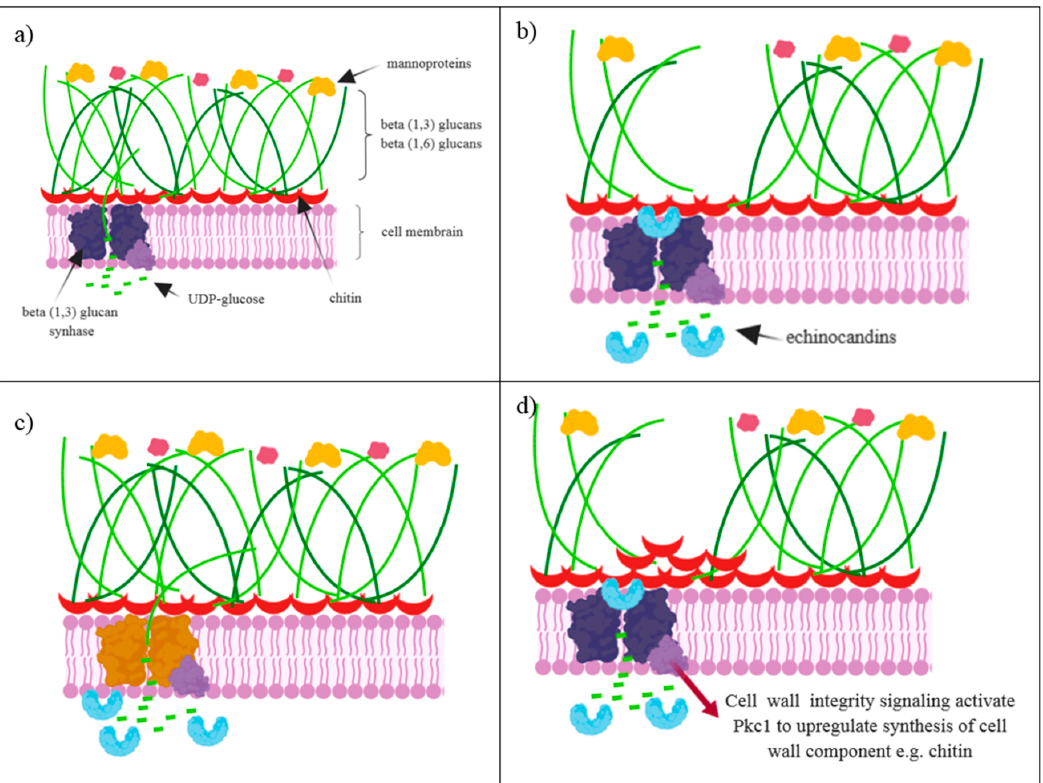
Figure 2. ( a ) The structure of a fungal cell wall; ( b ) Echinocandins act as noncompetitive inhibitors of β -(1,3)-D-glucan synthase. Inability of the microorganism to biosynthesize β -(1,3)-D-glucans leads to osmotic instability and cell death; ( c ) Nucleotides substitutions in the gene encoding glucan synthase contribute to the lack of echinocandin interactions with the enzyme; ( d ) Another mechanism of echinocandin resistance is to cell wall integrity, which is activated by RHO1 protein. The PKC, MAPK and calcineurin signaling pathways coordinate the regulation of the expression of chitin synthase gene and chitin synthesis.